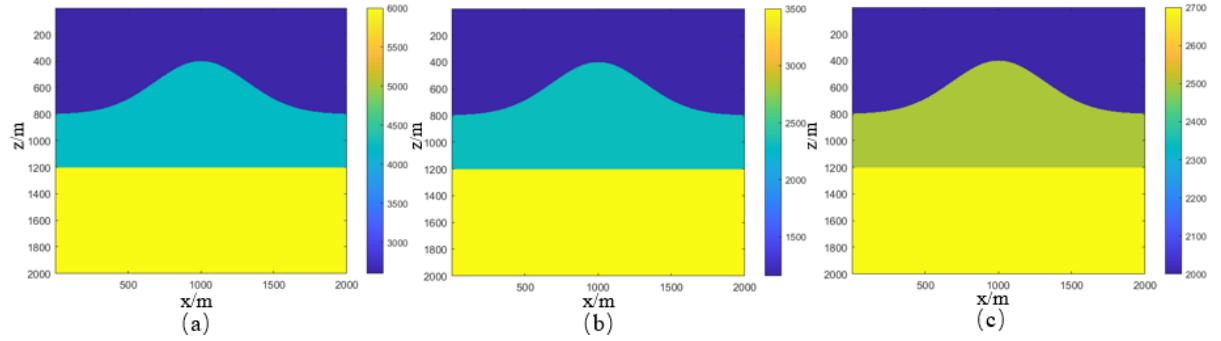
Figure 10. Velocity model of undulating interface: ( a ) longitudinal wave velocity; ( b ) shear wave velocity; ( c ) density.